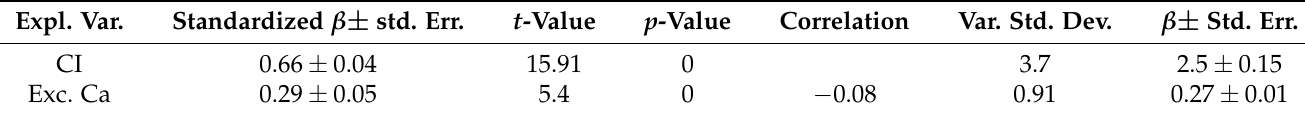
Table 4. Vegetation model results. β coefficients and their standards errors in standardized form together with their significance values and cross-correlation. β coefficients are converted to unstandardized form by multiplying their variable standard deviations. Colloid Index is defined in Equation (1). Exc. Ca. is defined as % of Cation Exchange Capacity (Table 1). Abbreviations: Expl., Exploratory; Var., Variable; std. err., standard error; std. dev., standard deviation. Expl. Var.